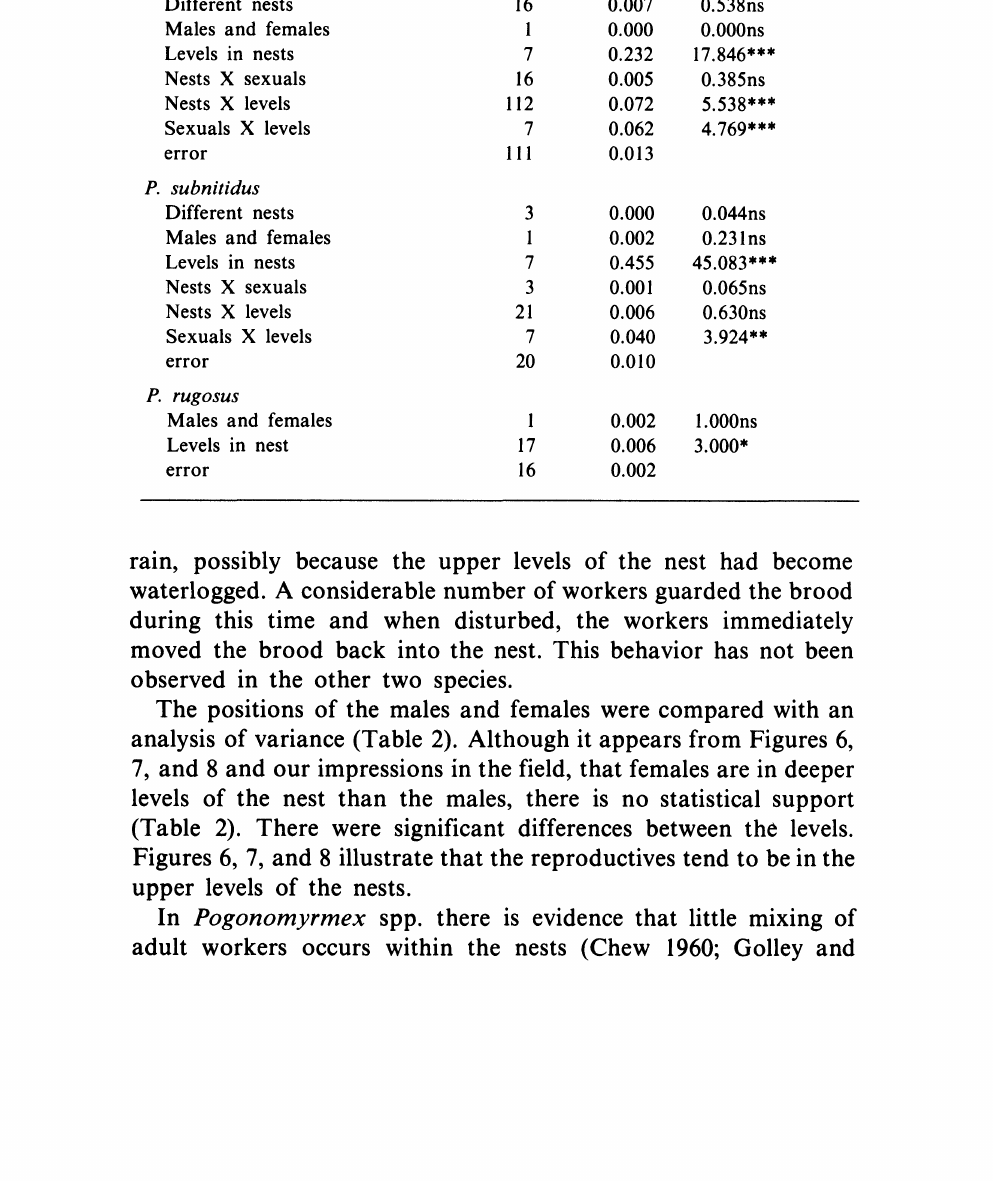
Table 2. Analysis of variance comparisons of the positions of males and females in 17 nests of P. montanus collected in 1978 and 1979, 4 nests of P. subnitidus collected in 1980, and one P. rugosus nest collected in 1979. (The data were subjected to an arcsin transformation before analysis.) Source df MS F P. montanus Different nests